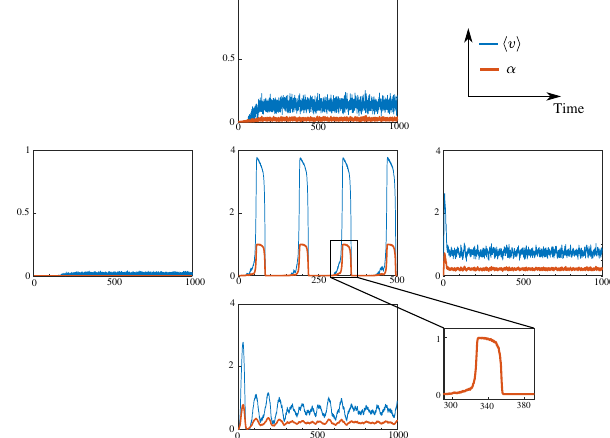
FIG. 12. Dynamics of the fraction of pioneers α as a function of time compared to the average voltage (blue). A smooth and rapid increase of α from 0 to 1 arises in the noise-induced oscillations case at the onset of a spike, while in all other cases α stabilizes.